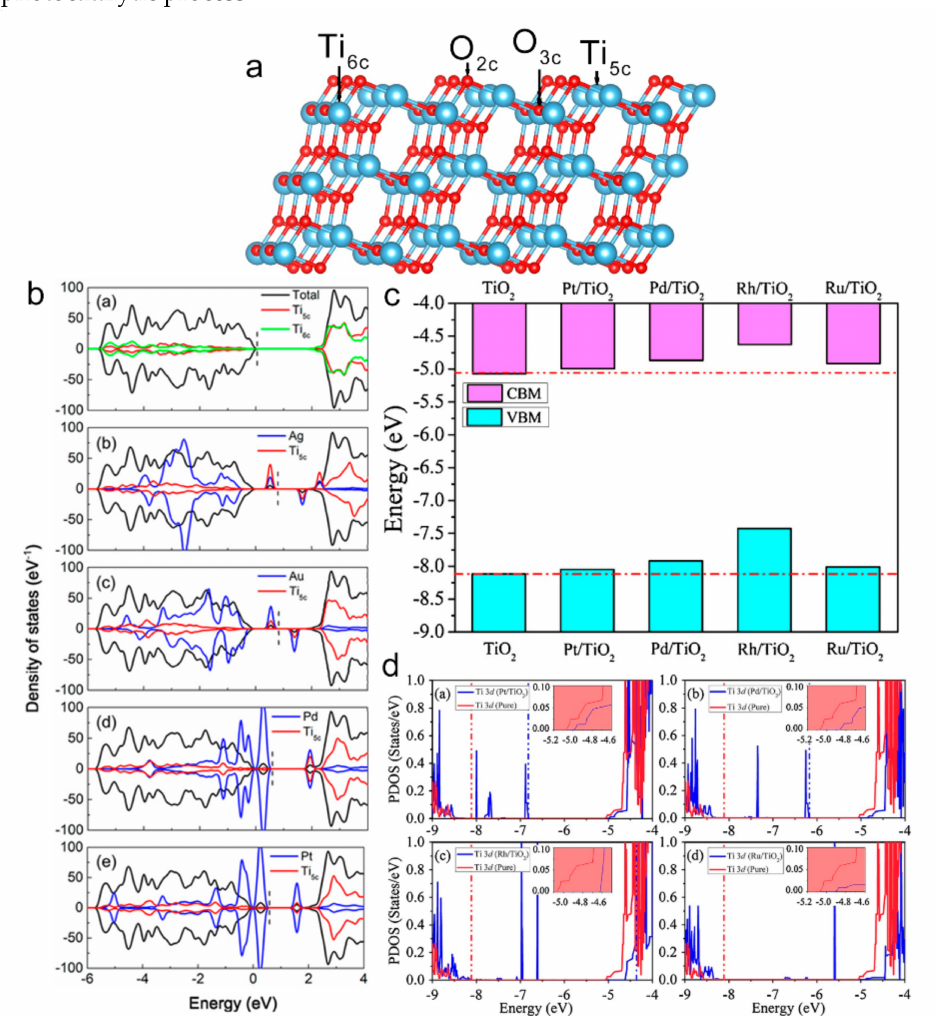
Figure 10. ( a ) Optimized structure of the plain anatase TiO 2 (101) surface. ( b ) Total and local DOS calculated with PBE + U for plain (001), Ag-, Au-, Pd-, and Pt-SA-(001) at 1/9 loading density. Ti 5c and Ti 6c of the panel a represent the DOSs contributed by surface 5-coordinated Ti atoms and subsurface 6-coordinated Ti atoms, respectively. For clarity, the DOSs of NM and Ti5c of panels b–e are magnified by 20 times, and all the TiO 2 valence bands which are mainly composed of O 2 p states are aligned roughly to 0 eV. The vertical short dashed line in each panel denotes the highest occupied state in each case. Adopted with permission from Ref. [121] ( c ) Change of conduction band minimum (CBM) and valence band maximum (VBM) of the host TiO 2 upon the single Pt, Pd, Rh, and Ru atom adsorption on anatase TiO 2 (101) surface, with the vacuum level set to zero. ( d ) Calculated partial density of states (PDOS) of the topmost surface Ti 3 d orbits for single Pt, Pd, Rh, and Ru atom adsorbed anatase TiO 2 (101) surface. The vacuum energy level is set to zero. The insets show the band edge of the conduction band, and the vertical dashed lines represent the Fermi level. ( a , c , d ) Adopted with permission from Ref.